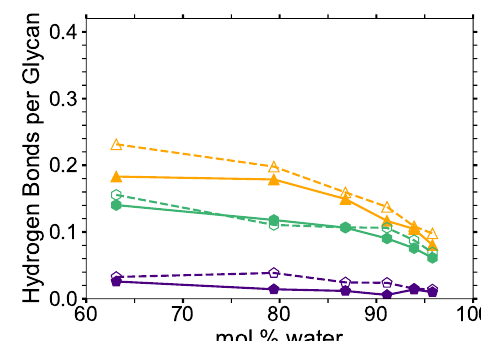
( b ) Cl-strand : center (purple), corner (orange), and the strands above the corner strands (green).